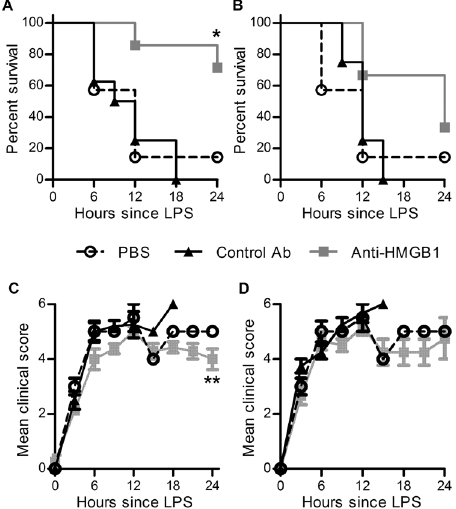
Figure 3. Ovine anti-HMGB1 pAb therapy improves survival in an in vivo model of murine endotoxaemia. Adult male and female B6 mice were prophylactically administered 20 mg/kg anti-HMGB1 pAb ( n = 7), control pAb ( n = 7) or PBS ( n = 7) via IP injection one hour before IP injection of 20 mg/kg LPS (A&C). In a therapeutic model, mice were administered 20 mg/kg anti-HMGB1 pAb ( n = 6), control pAb ( n = 4) or PBS ( n = 7) one hour after LPS administration (B&D). Experimental mice were monitored over twenty-four hours for clinical score and euthanised if predetermined humane endpoints were reached. Survival ( A , B ) and mean clinical score ( C , D ) of groups is represented. Survival curves were compared to controls using the Mantel-Cox test and clinical score data compared to PBS control via two-way ANOVA, with significance denoted as: * P < 0.05, ** P <